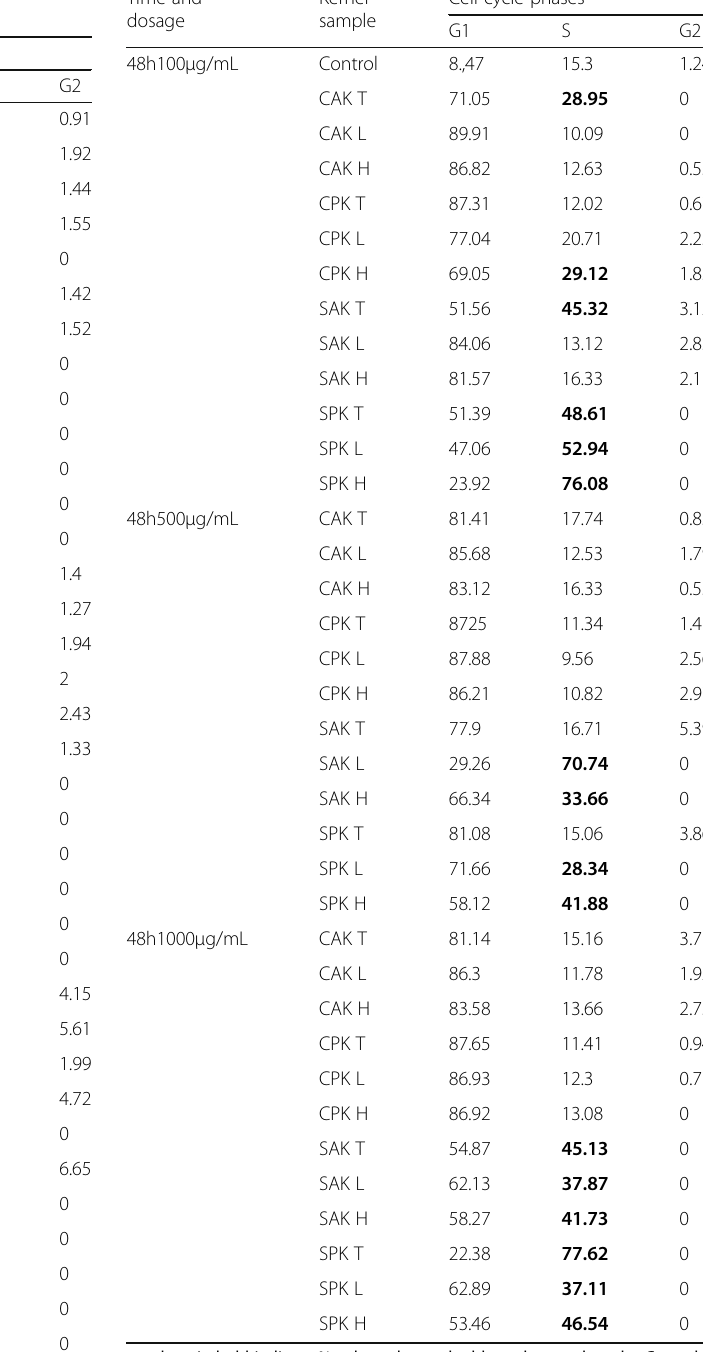
numbers in bold indicate % values almost double and more than the Controls values for cells in the